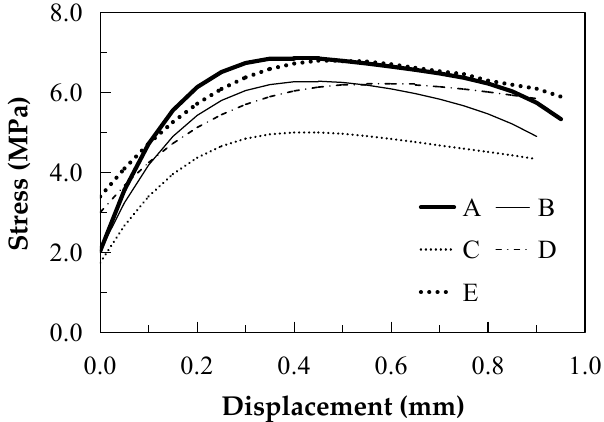
Figure 16. Tensile stress–displacement curve of the single seam with different sand particle sizes.